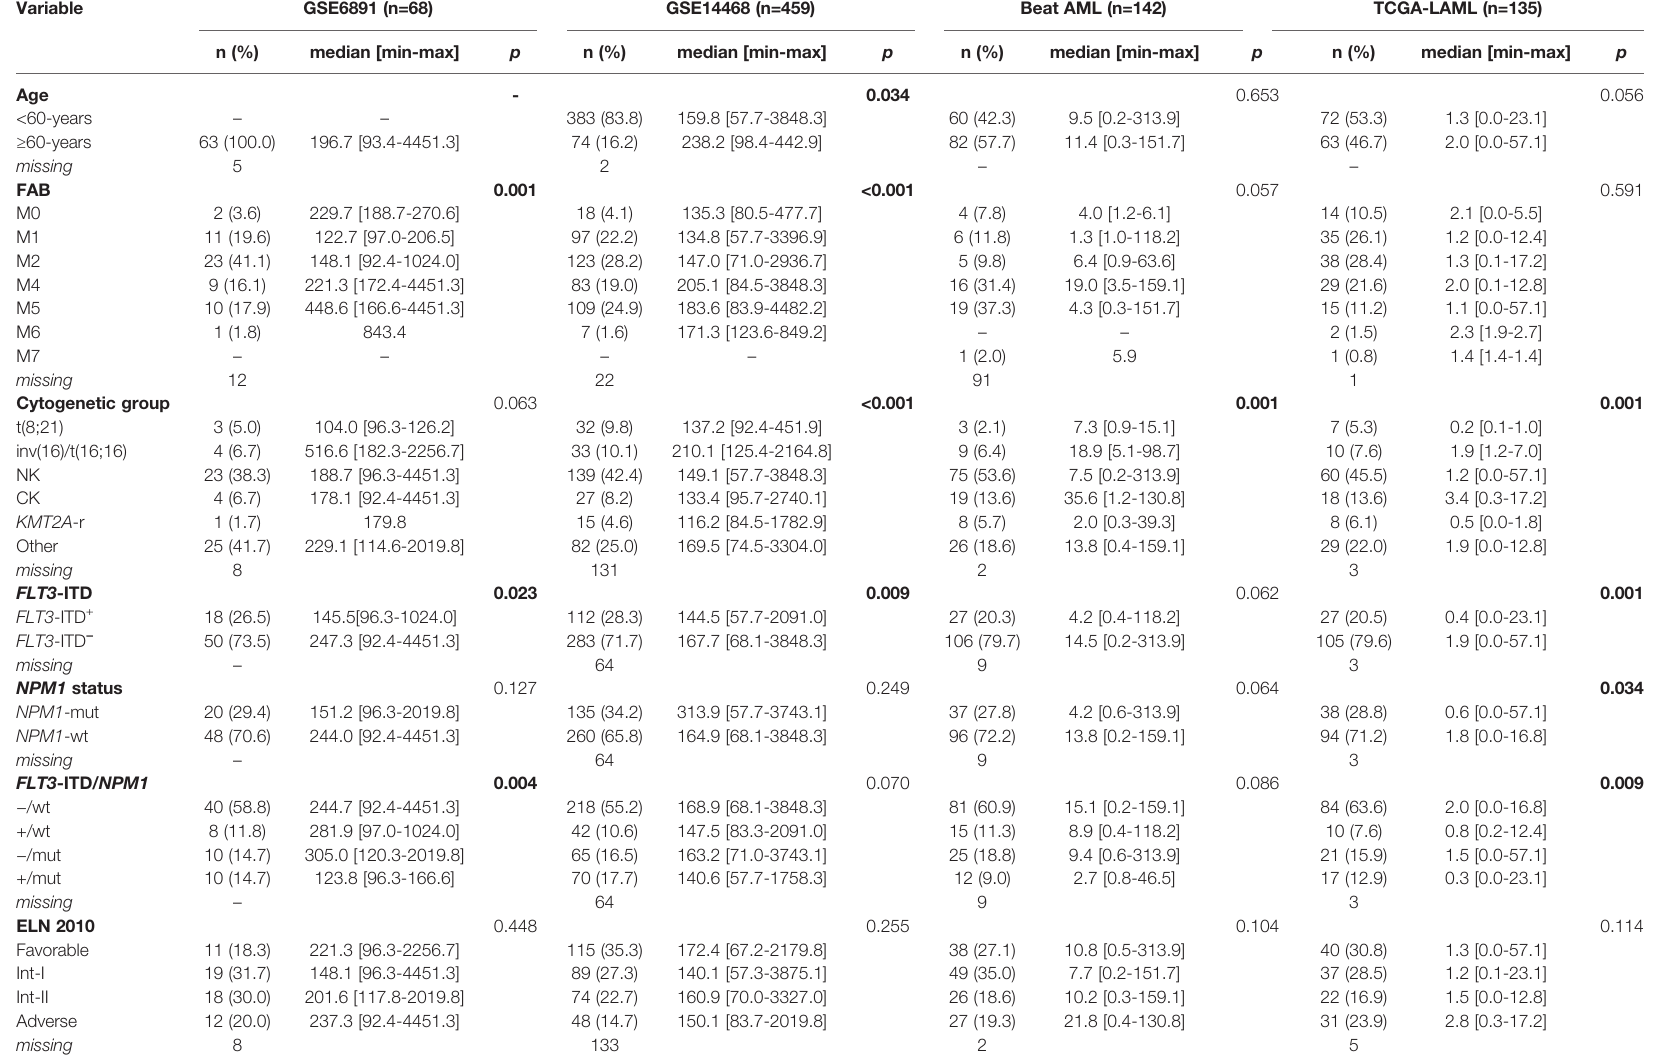
TABLE 1 | Association between ADM expression levels and clinical/molecular data across public datasets.